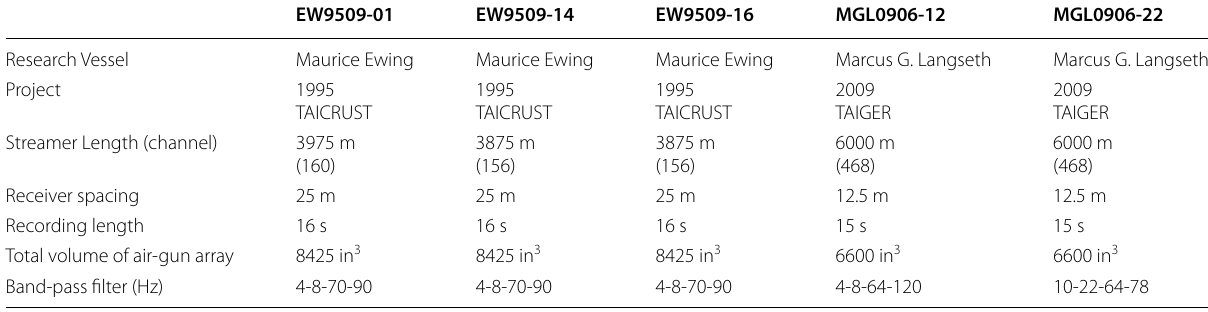
Table 1 Parameters of LMCS